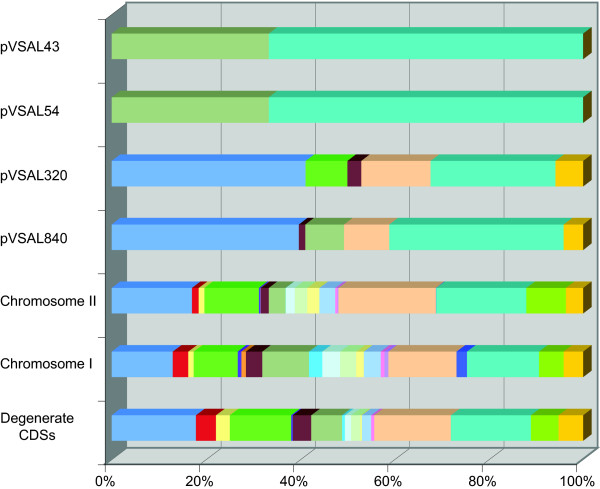
Representation of the functional distribution of CDSs encoded by the six replicons of A. salmonicida strain LFI1238. The bottom bar summarizes the functional distribution of degenerated genes from all six replicons. Colour coding for the CDSs based on a modified hierarchical protein class coding scheme of Monica Riley's [78] are: light blue, unknown function; red, information transfer; yellow, protection responses; green, transport and binding proteins; violet, adaptation; orange, cell division; plum, macromolecule metabolism; grey, macromolecule synthesis and modification; sky blue, amino acid biosynthesis; light turquoise, biosynthesis of cofactors; light green, central intermediary metabolism; light yellow, degradation of small molecules; pale blue, energy metabolism – carbon; pink, fatty acid biosynthesis; purple, nucleotide biosynthesis; light orange, cell envelope; blue, ribosome constituents; aqua, foreign DNA; lime, regulation; gold, miscellaneous.